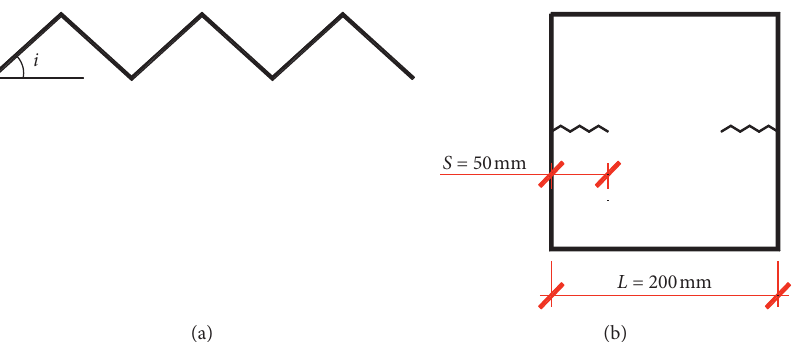
Figure 3: Details of the coplanar jointed rock mass. (a) Coplanar joint undulation angle. (b) Schematic diagram of coplanar joint